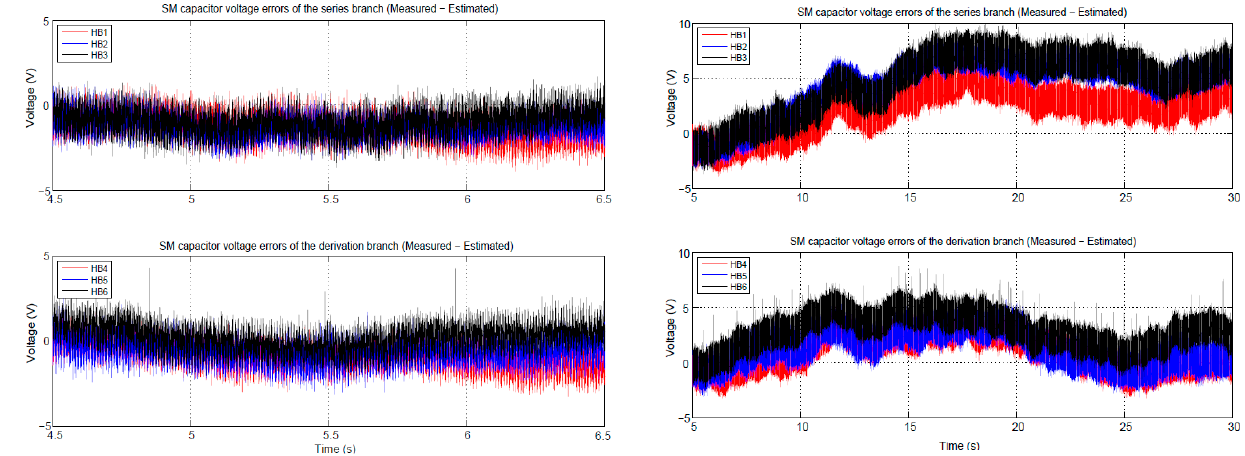
Figure 9. Capacitor voltage error evolution. Left side: short duration; right side: long duration.